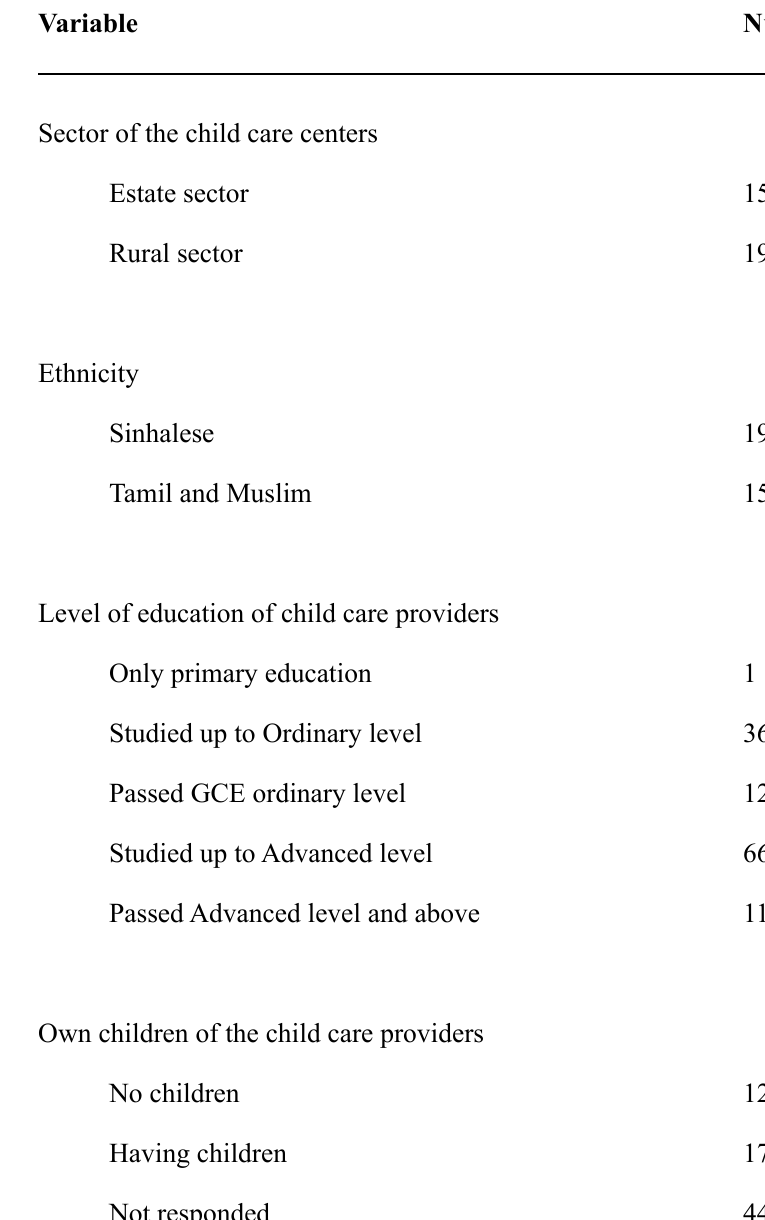
Table 1: Distribution of the study population by selected socio demographic variables (n=344)